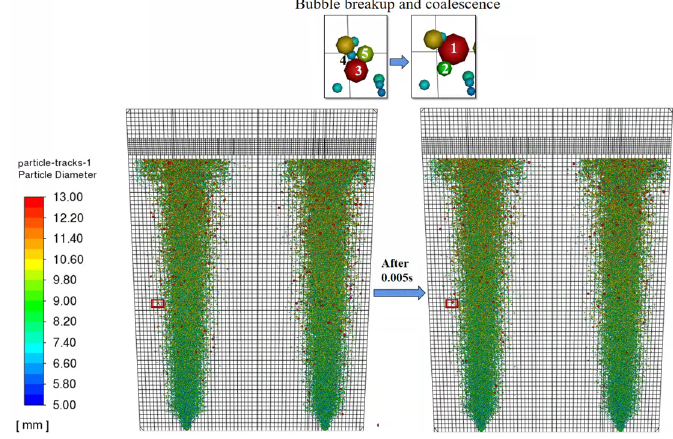
Figure 5. Bubbles coalescence and breakup.